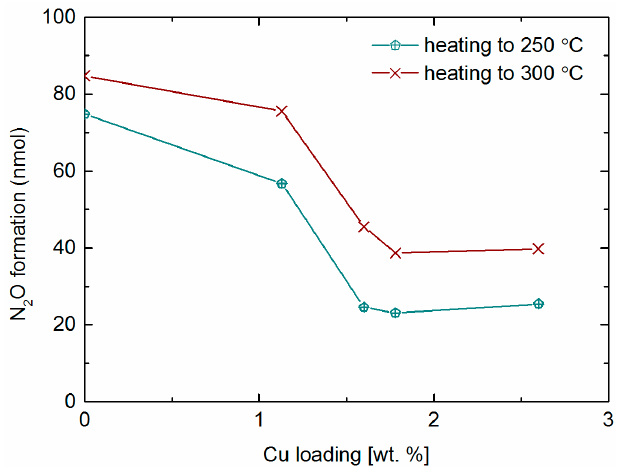
Figure 10. N 2 O released while ramping from 200 to 250 °C and 250 to 300 °C during fast SCR.